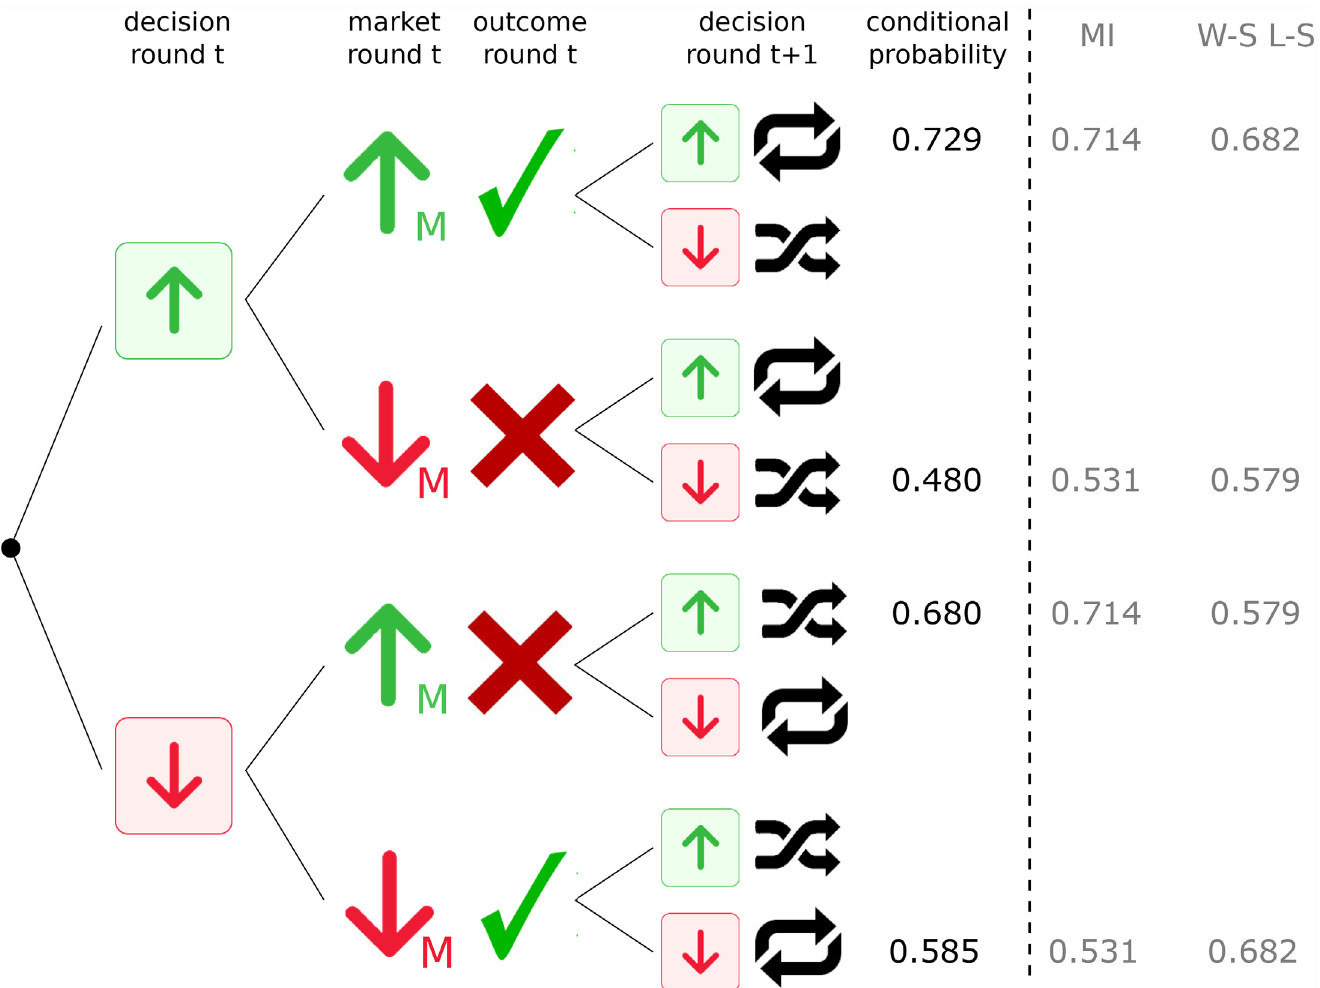
Fig 5. Two-step Markov chain to observe that Market Imitation is the dominant emerging strategy. The tree of possibilities for the probability to choose “ up ” or “ down ” depending on two conditions: the direction of the market in the previous round and the performance of the volunteer (success or not) in the previous round. The tree includes the conditional probabilities of the Market Imitation and Win-Stay Lose-Shift emerging strategies to observe which of them is the dominant strategy. We observe that Market Imitation conditional probabilities are closer to the aggregated conditional probabilities corresponding to the event to “ Follow and Strategy ” than those from the Win-Stay Lose-Shift emerging